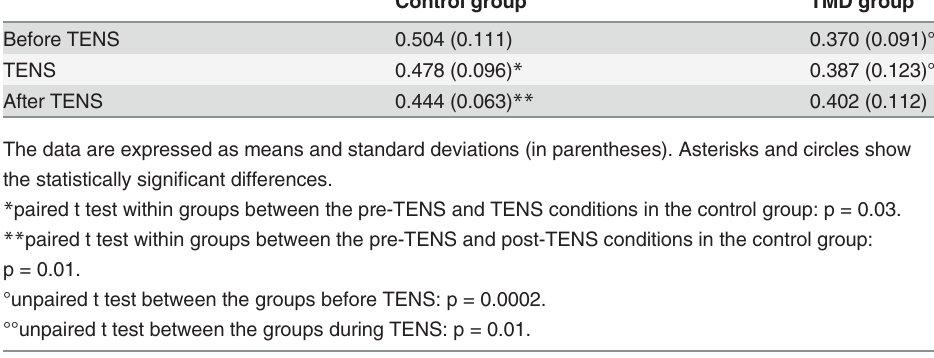
Table 3. Comparison of the Pupil Size and Yellow-Green/Infrared Light (L/D) Ratio between the Con- trol and TMD Groups. L/D ratio L/D ratio Control group TMD group Before TENS 0.504 (0.111) 0.370 (0.091)° TENS 0.478 (0.096) * 0.387 (0.123)°° After TENS 0.444 (0.063) ** 0.402